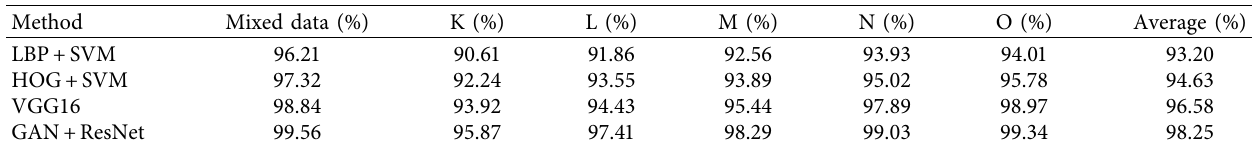
Table 7: Accuracies of different